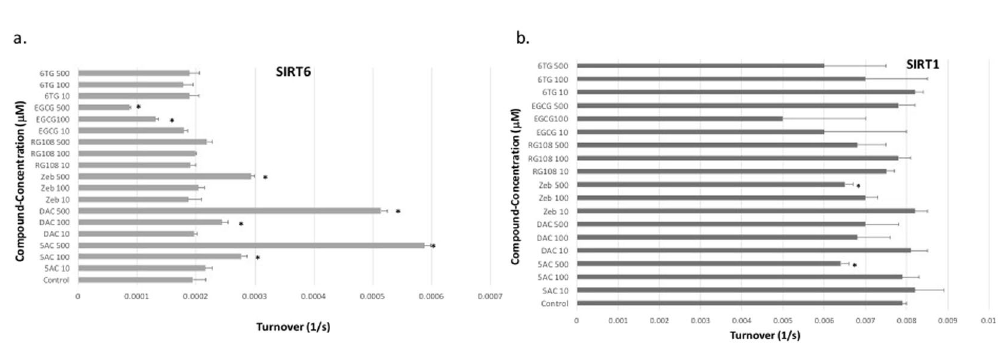
Figure 2. Modulation of the enzymatic activity of SIRT6 and SIRT1 by DHA. Recombinant SIRT6 (a) and SIRT1 (b) proteins were incubated with different concentrations (10, 100 and 500 μ M) of DAC, 5AC, zebularine (Zeb), RG-108, EGCG and 6-thioguanine (6TG) as described under methods. Data represent the mean of 4 replicates ± SD. * Indicates significant difference at p <